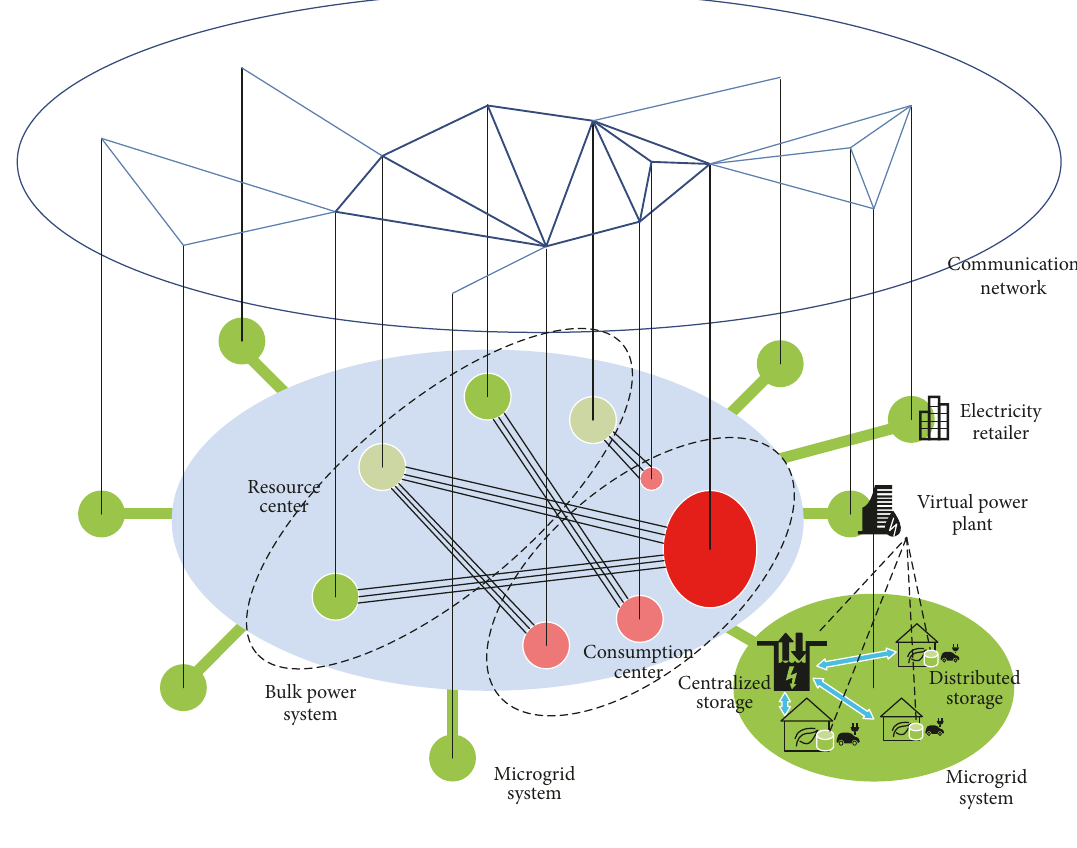
Figure 1: Framework and vision of energy Internet in